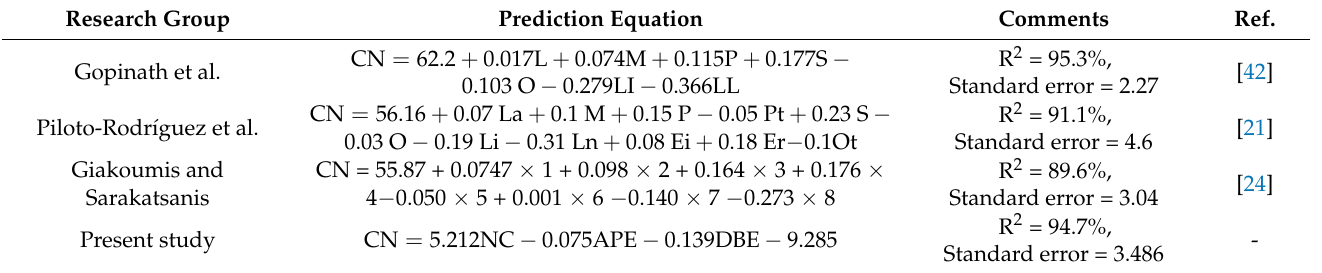
Table 2. Comparison of prediction capability of the present formula with competitive formulae in the literature.